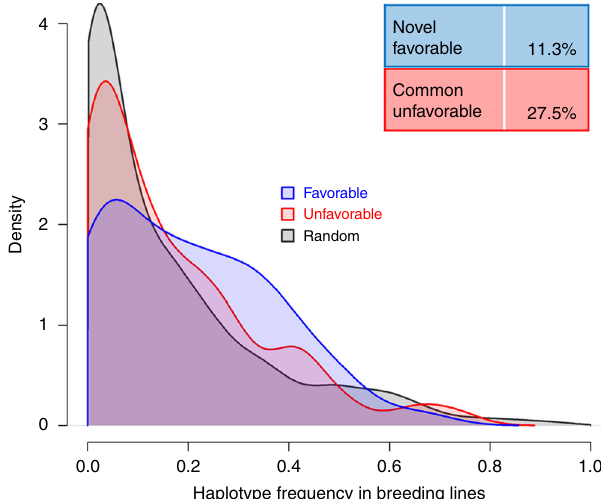
Fig. 4 Favorable and unfavorable landrace haplotypes in breeding lines. Density estimation for favorable ( n = 53, blue), unfavorable ( n = 80, red), and random ( n = 500, gray) haplotypes in 65 breeding lines. Haplotypes signi fi cantly associated with four early plant development traits (EV_V4, EV_V6, PH_V4, and/or PH_V6) in landrace-derived DH libraries exhibiting a distance > 1 Mb and/or r 2 < 0.8 were considered. Six favorable haplotypes (11.3%) were absent in the breeding lines. Out of the 80 unfavorable haplotypes, 22 (27.5%) were common in the panel of breeding lines, i.e., exhibiting a frequency larger than the upper quartile (>0.231) of random haplotypes. Source data are provided as a Source data fi